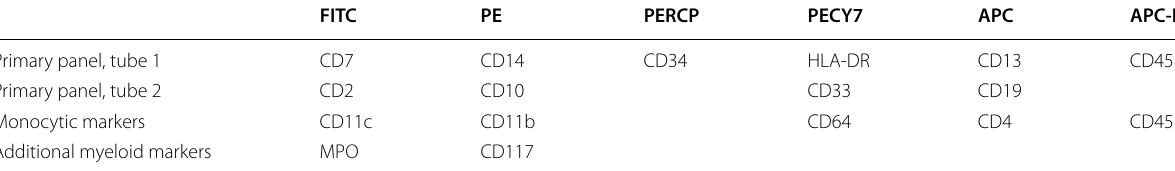
Table 1 The monoclonal antibodies used for immunophenotyping by flowcytometry